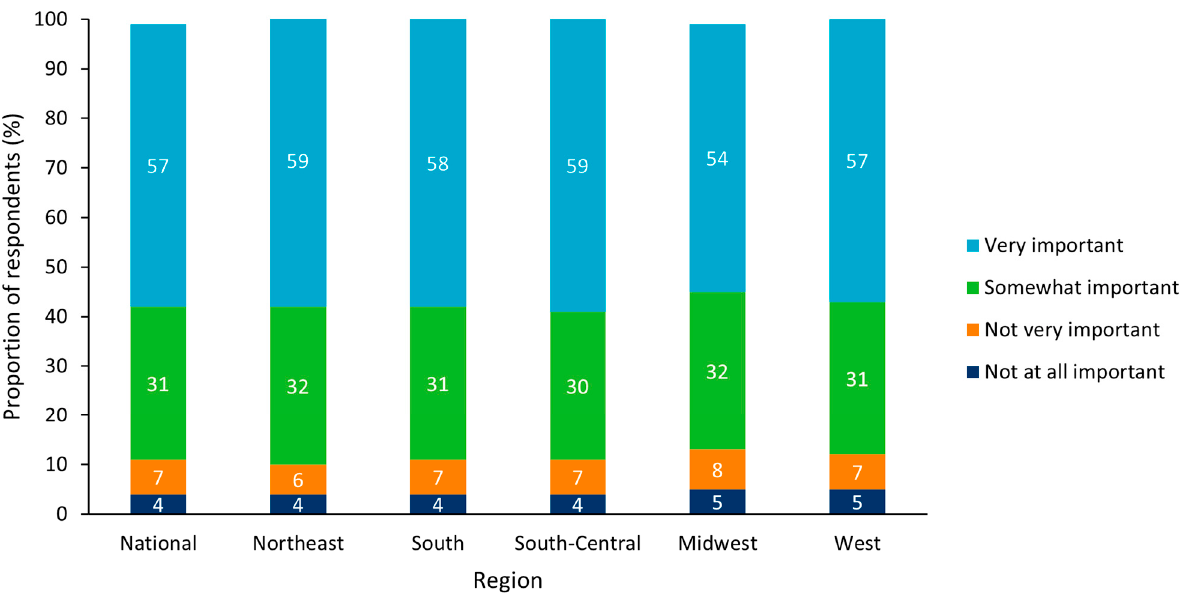
Figure 5. Perceived importance of immunization information systems (IIS) for all respondents without religious objections to vaccination (n = 4917). Results split by US region.